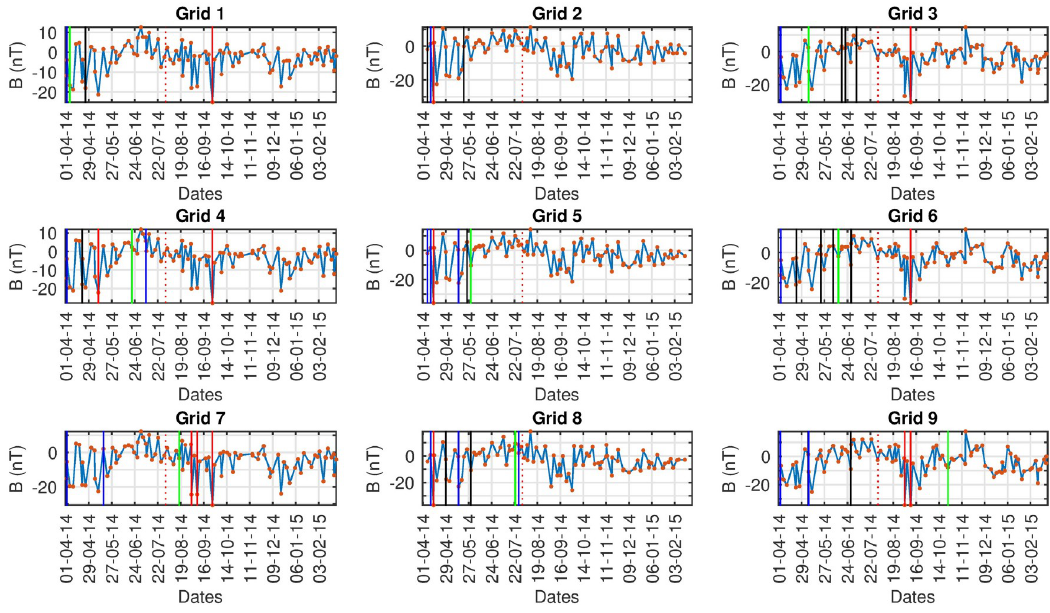
Fig 8. AD results Swarm A, red: CE , black: Fuzzy, blue: D-SAX , green: SAX.